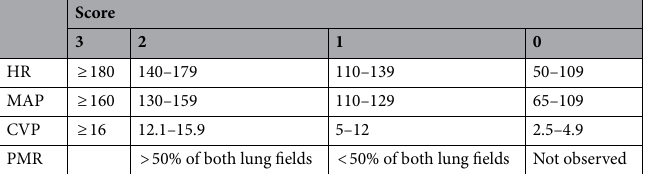
Table 2. General empirical scoring. HR heart rate, MAP mean arterial pressure, CVP central venous pressure, PMR pulmonary moist